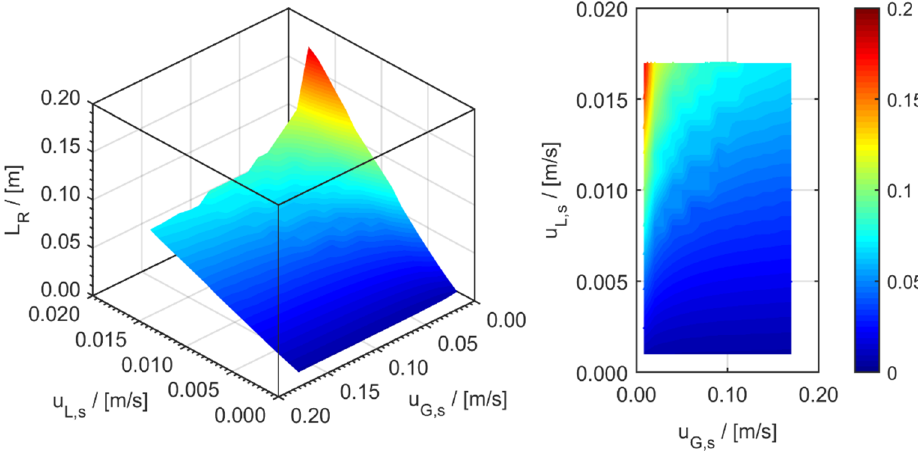
Figure 15. Required reactor length of foam-packed minichannel reactors operating at different gas and liquid superficial velocities.